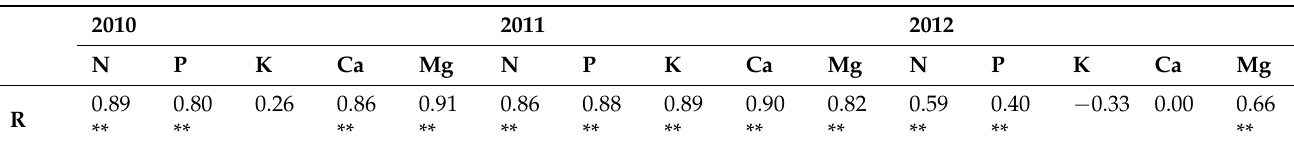
Table 2. Correlation results of biomass of rhizome per stem and nutrient concentration in stem (** denotes that R is significant at p > 0.05).